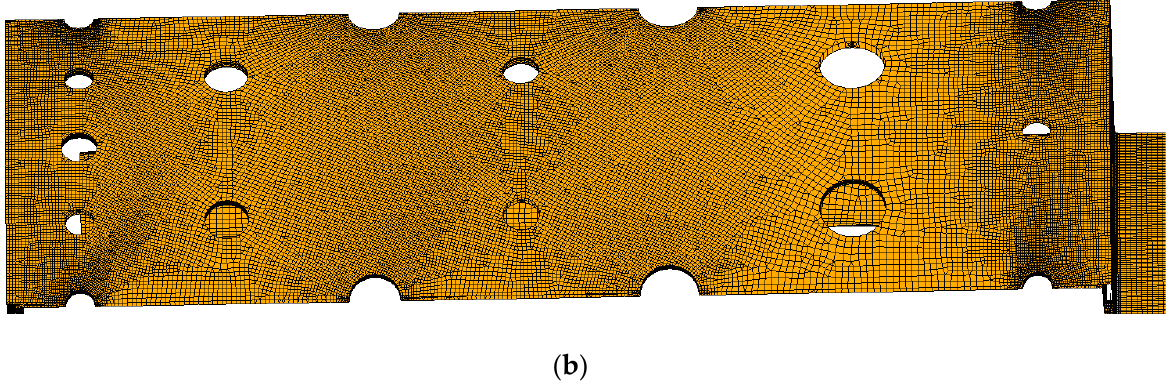
Figure 2. Computational domain and mesh of the combustion chamber sector: ( a ) side view; ( b ) top view.